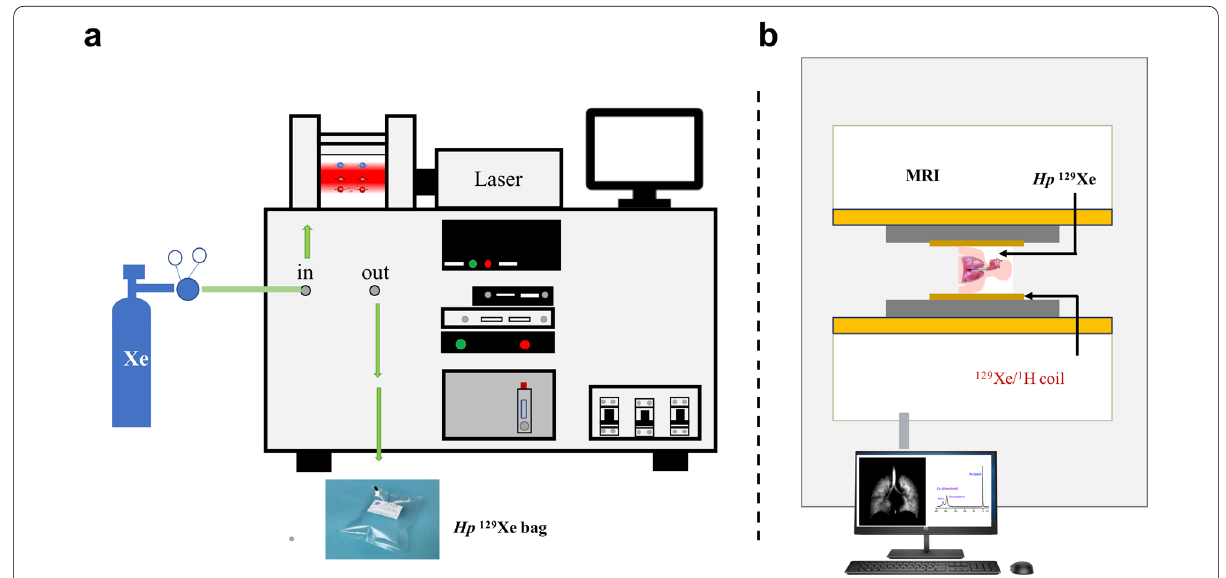
Fig. 6 The workflow of hyperpolarized Xe 129 MRI in biomedical imaging. Preparation of the hyperpolarized Xe 129 ( a ), and the magnetic resonance imaging of the lung using Xe 129 ( b